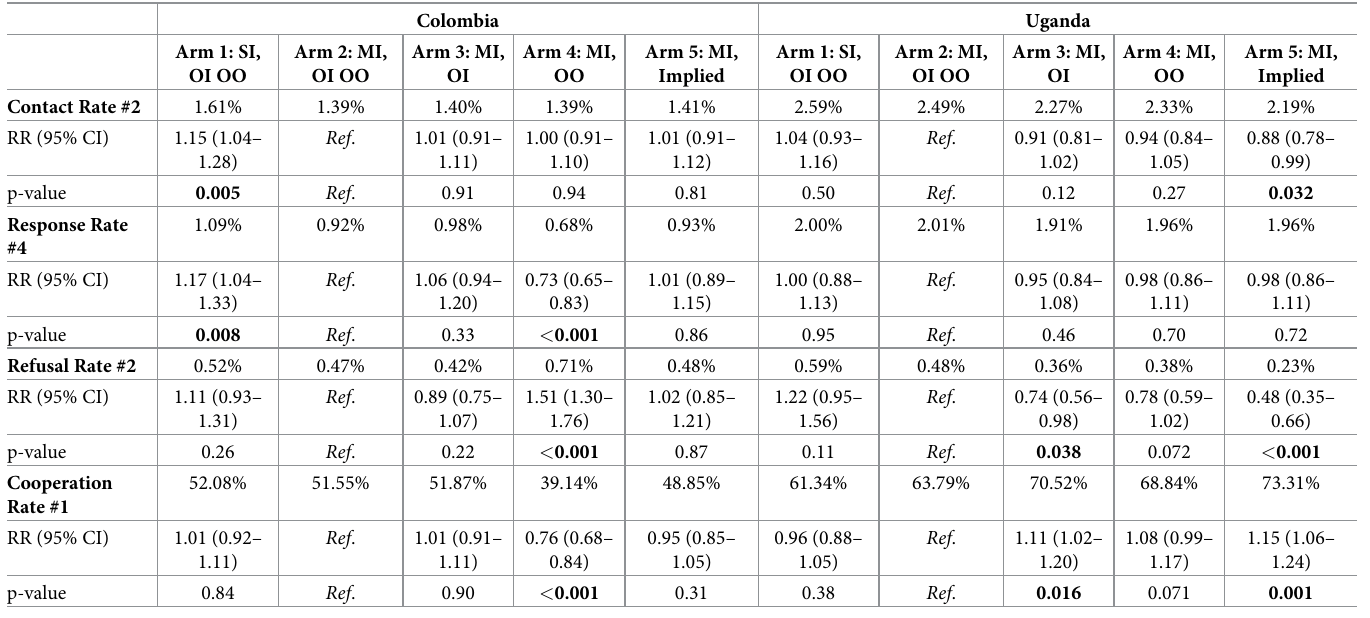
Table 3. Survey rates and risk ratios among the modified consent arms with the modified opt-out opt-in arm as reference in Colombia and Uganda. Colombia